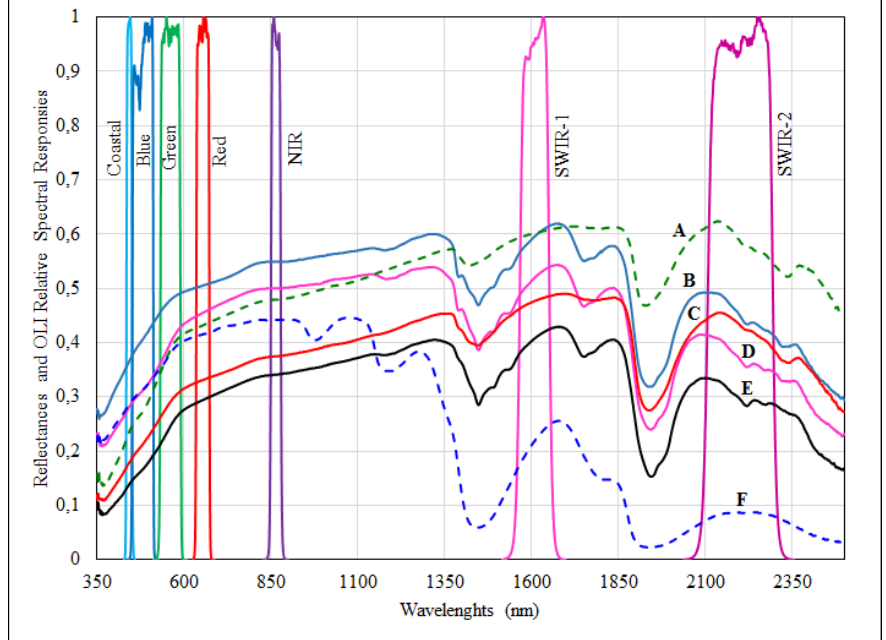
Figure 5. Landsat-Operational Land (OLI)-relative spectral response profiles characterizing the filters of each visible- and near-infrared (VNIR) and shortwave infrared (SWIR) spectral band, and the spectral signatures of six soil samples with different electrical conductivity (EC- Lab ) values: non-saline ( A ), low ( B ), moderate ( C ), high ( D ), very high ( E ), and extreme salinity ( F ).